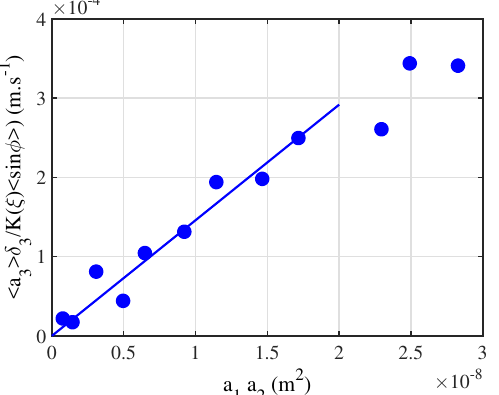
Figure 10. Rescaled amplitude of the daughter wave a 3 as a function of the product of the mother wave amplitudes a 1 a 2 . The frequencies of the triad are f 1 = 15 Hz, f 2 = 18 Hz, and f 3 = 33 Hz, and the angle between the mother waves is α 12 r = 54 deg. The rescaling involves φ = φ 2 − φ 2 − φ 3 ≈ π /2—the measured phase locking between the triad components, δ 3 —the damping rate of the wave 3 given by the inextensible film model (Equation (72)), and a propagation factor K ( ξ ) , depending on the measurement point (Equation (85)). The slope of the line provides the experimental value γ 3 of the growth rate of the wave 3. The amplitudes and the phases are measured with a laser vibrometer. (Reprinted with permission from Ref. [63] Copyright 2022 American Physical